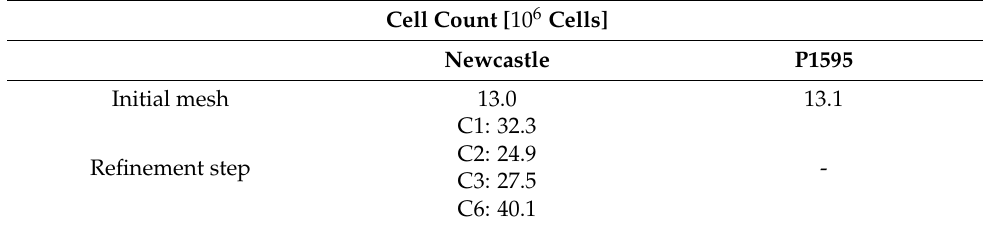
Table 4. Size of initial mesh and examples of the applied refinements.